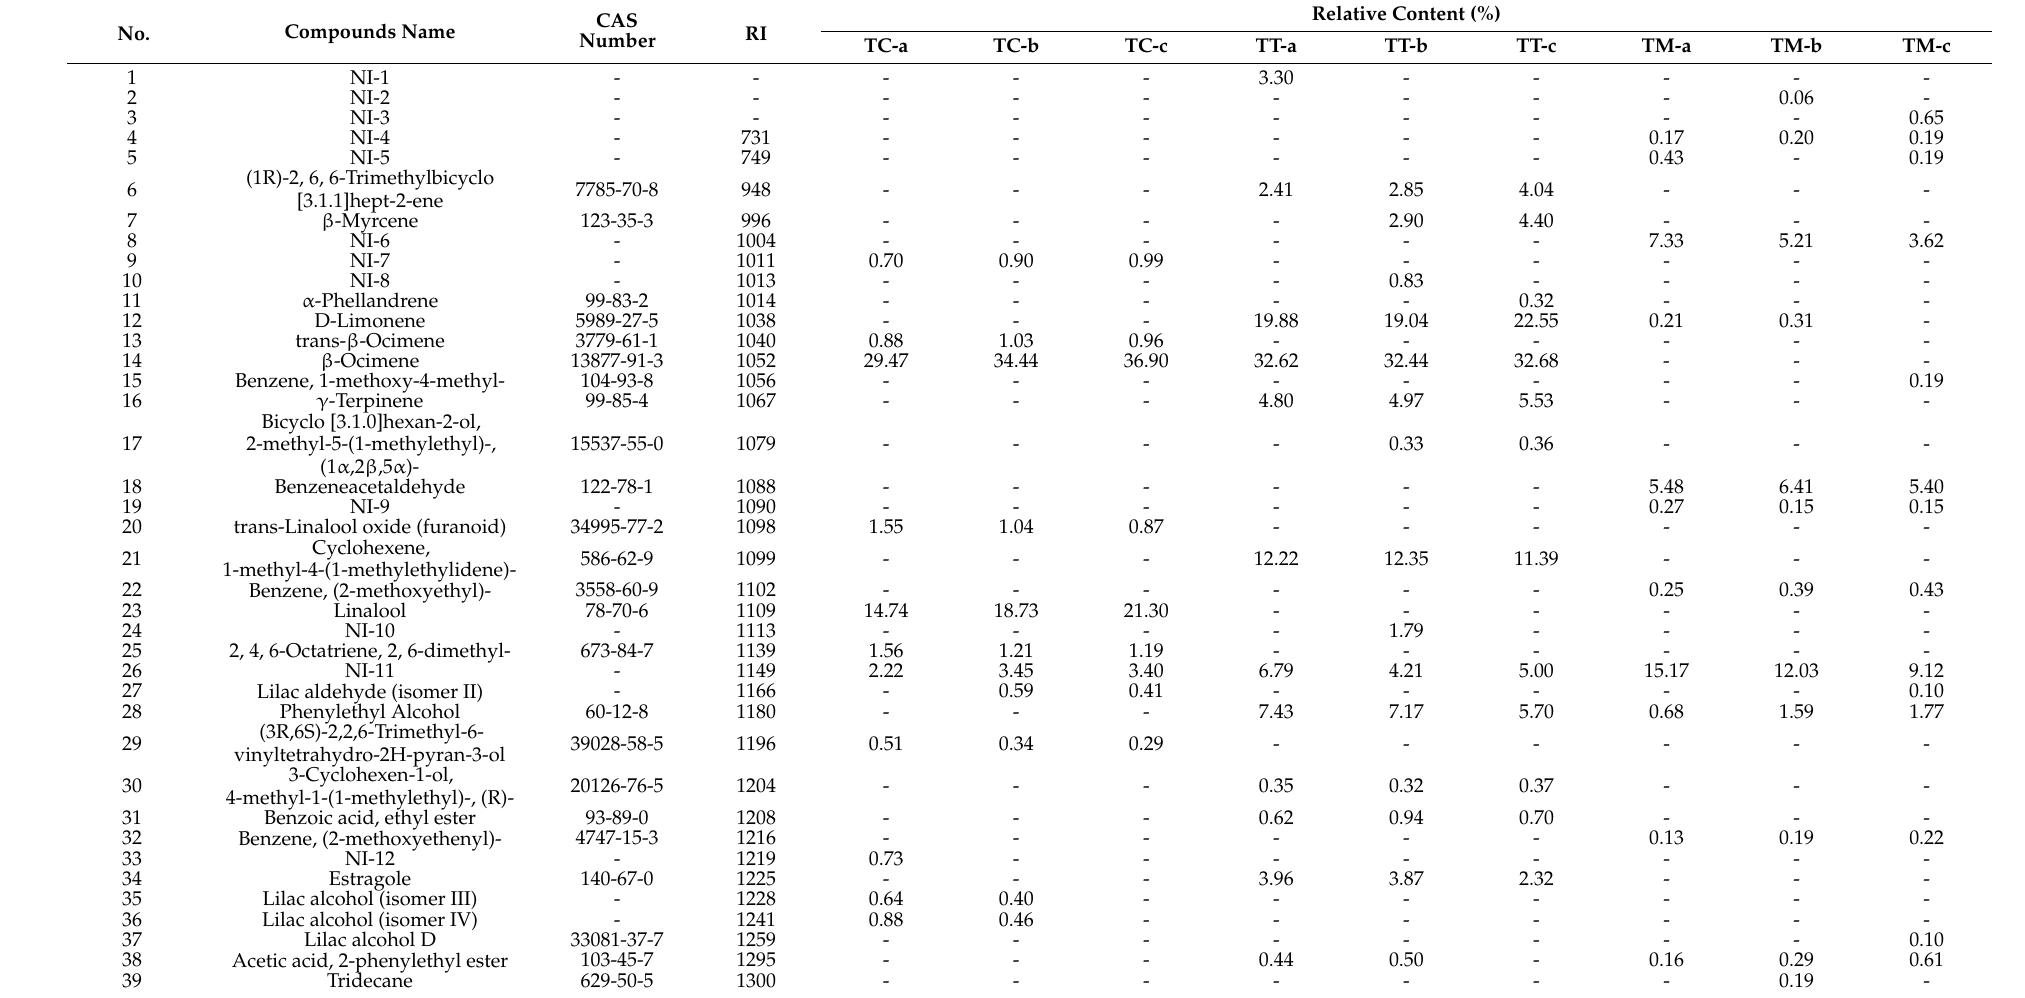
Table 2. Aroma components and relative contents in samples of the three species from Tilia